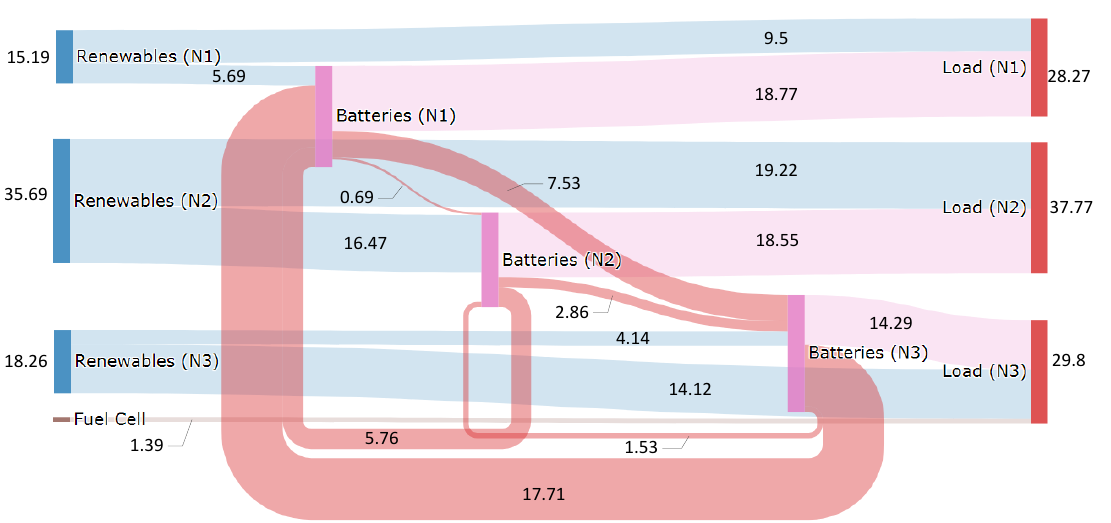
Figure 17. Total daily energy flow (kWh) in the microgrid with the NMPC enabled and with unpredicted conditions.